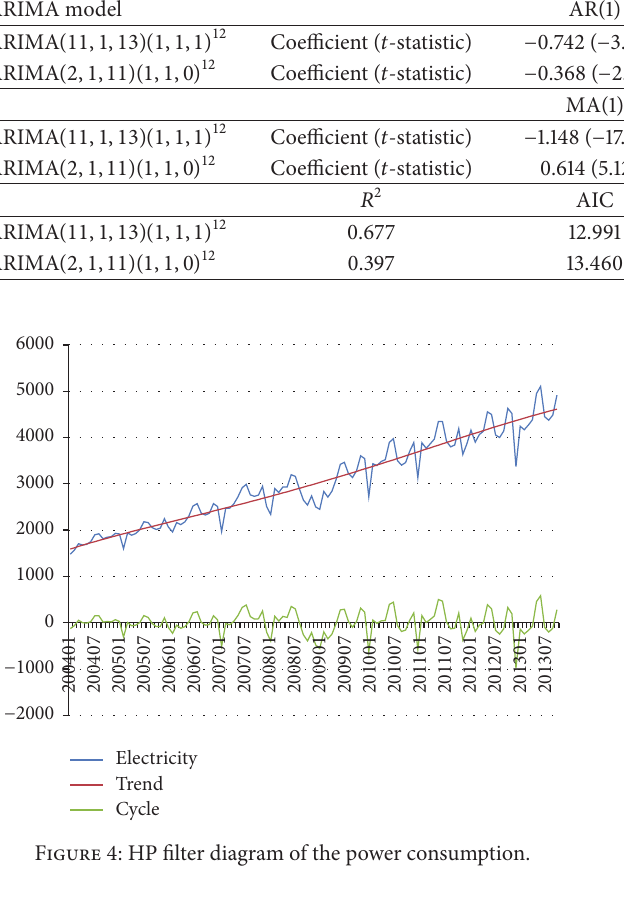
irregular change. And as time goes on, the fluctuation range is more significant.